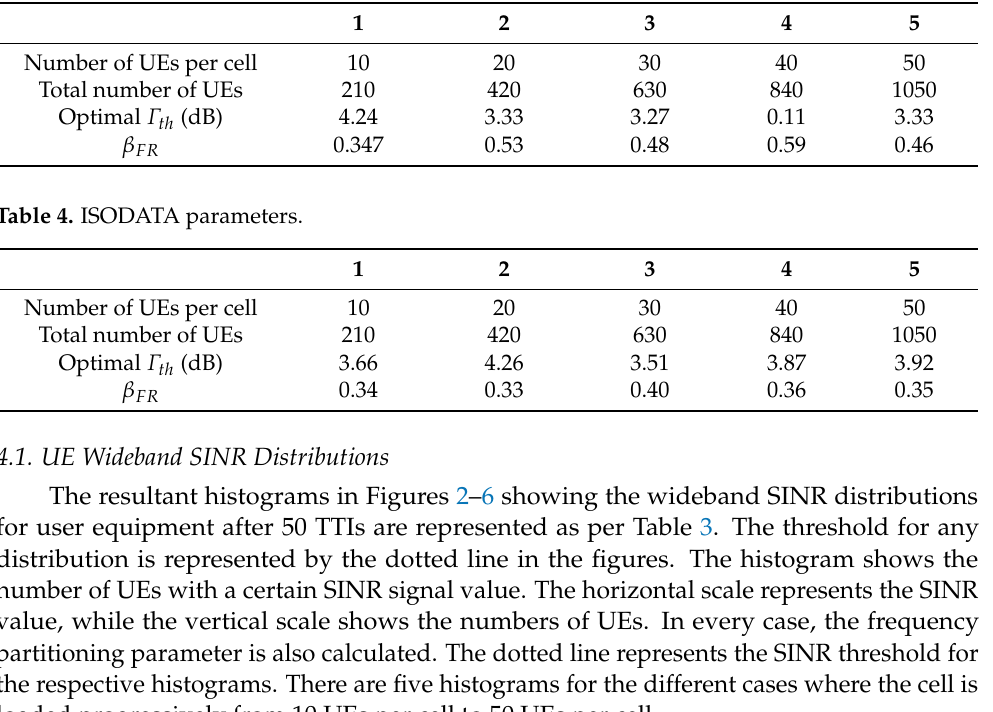
Table 3. NIR parameters.